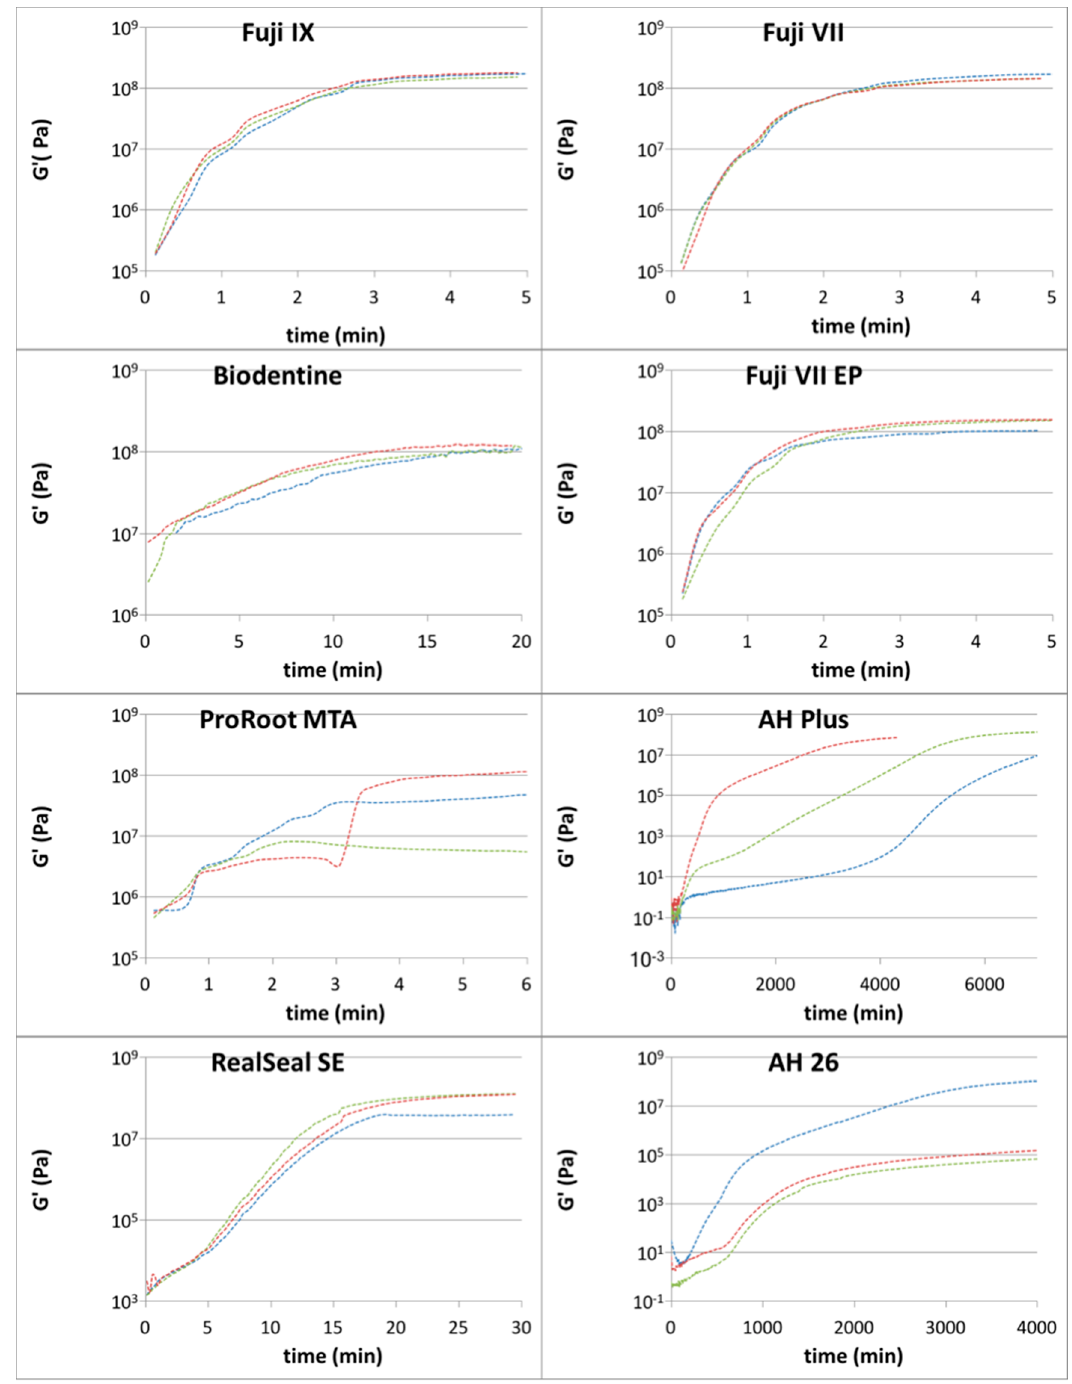
Figure 2. Elastic (G’) modulus of tested dental cements over time. Different color plots are the trend lines for different replicate samples of the same material.